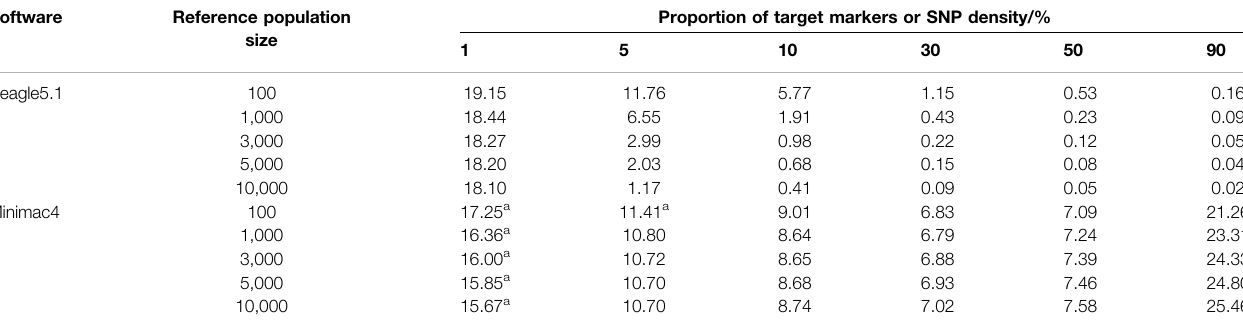
Proportion of target markers or SNP